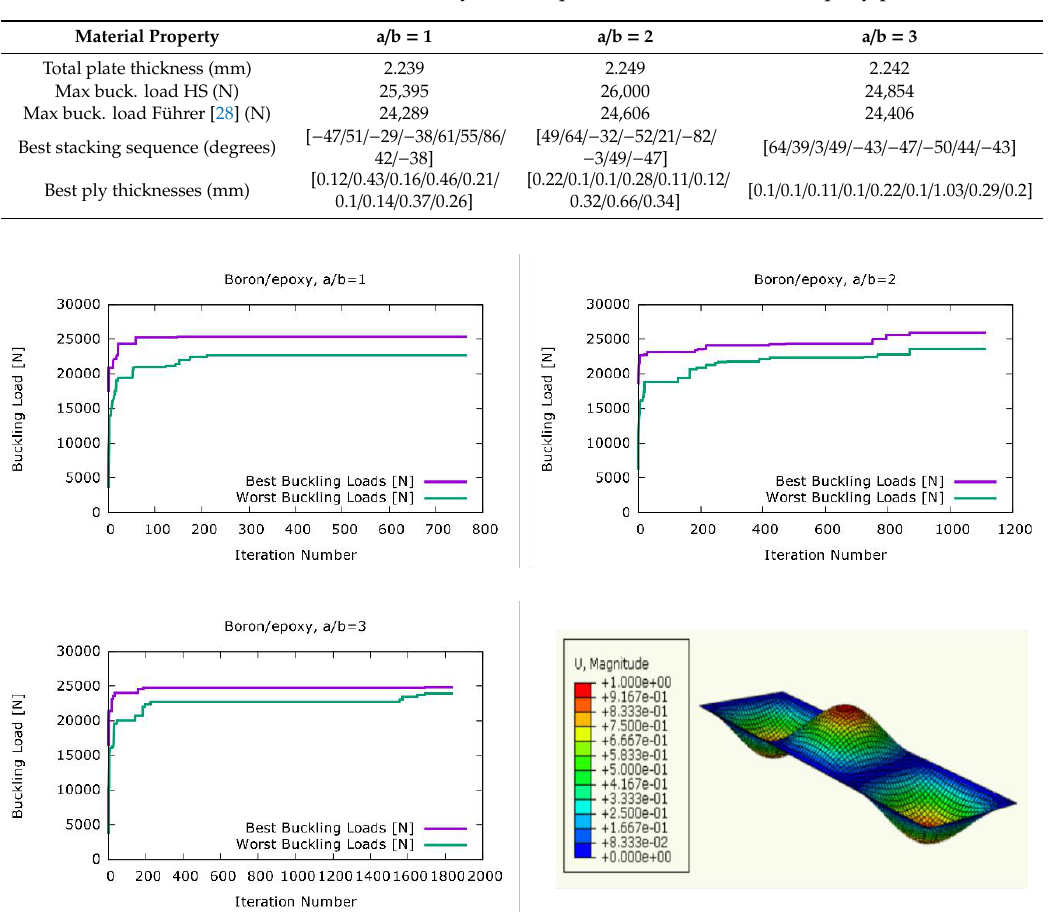
Table 3. Material properties of boron/epoxy plates.